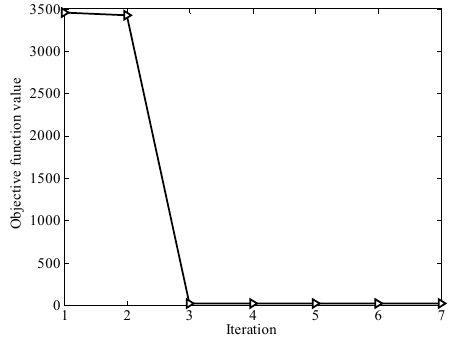
Figure 7. Convergence curve of objective function.